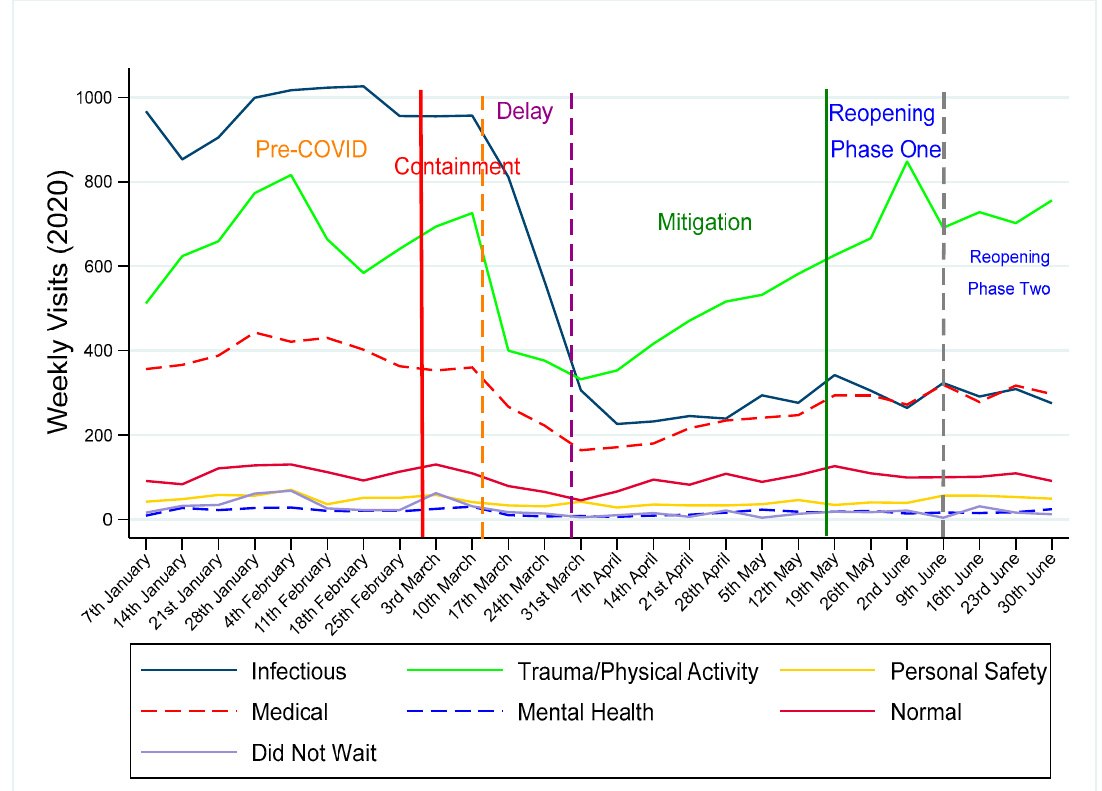
Figure 3. Emergency department attendance by category of diagnosis. Infectious includes respiratory, ENT, infectious diseases and digestive; Trauma/Physical Activity refers to sprains, fractures and bruising, head injuries, burns, lacerations and orthopaedic; Personal Safety includes toxicology, foreign objects (insertion/ingestion) and child protection/assault; Medical includes dermatology, genitourinary & gynaecology, neurology, surgical, general, ophthalmology and infancy related; Mental Health refers to psychosocial presentations; Did Not Wait refers to patients who registered on arrival but did not wait to see a doctor. This varies with the average wait time and is generally higher during busy period.